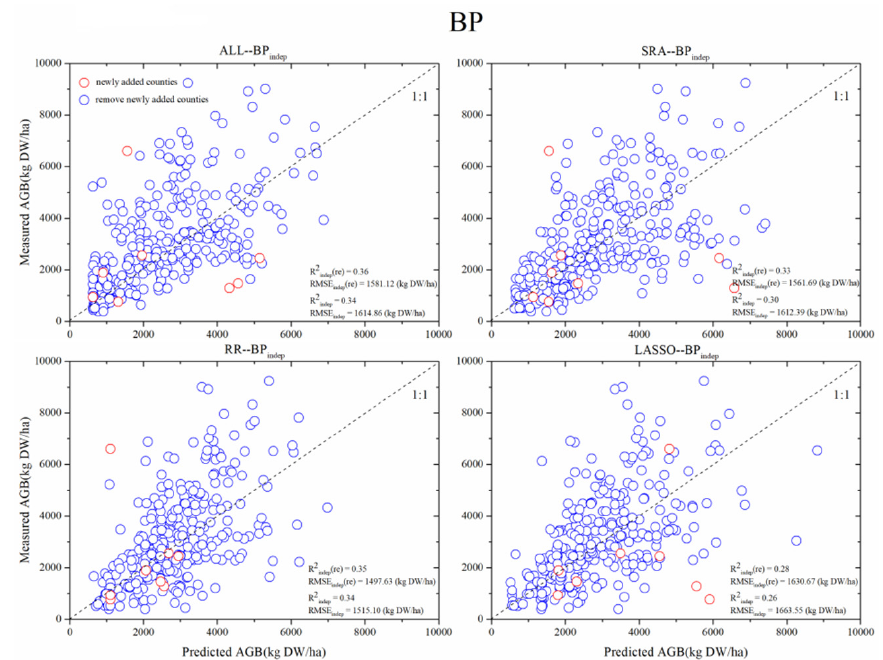
Figure 4. Assessing the accuracy of the independent AGB validation set simulated when expanding the spatio-temporal distribution by using different methods.